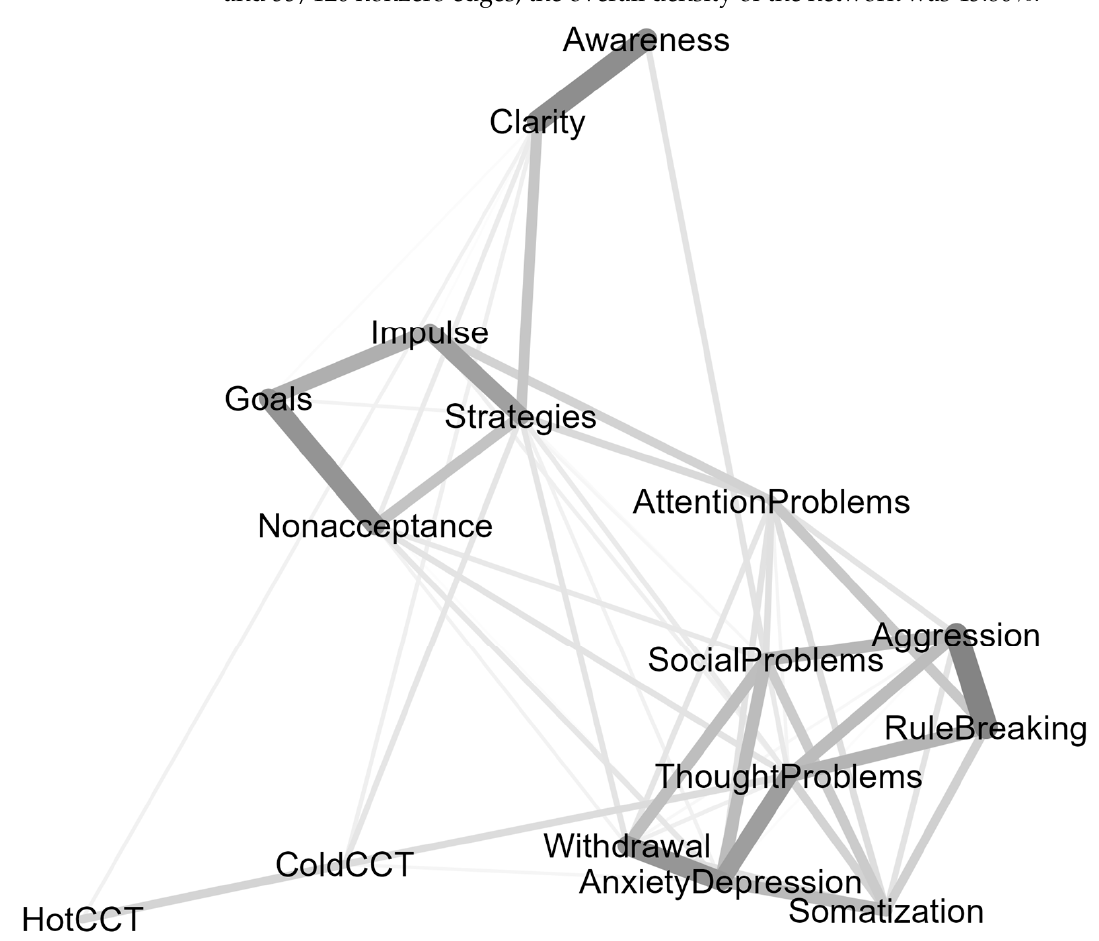
Figure 3. A network containing the eight syndrome scales of the Youth Self-Report, the six subscales of the Difficulties in Emotion Regulation Strategies, and risk propensity in decision-making tasks. The edge thickness represents the strength of an association.